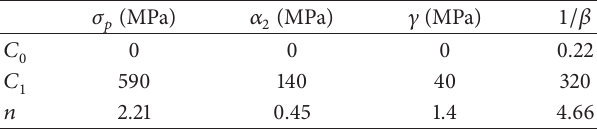
Table 2: Material constants for aluminum foam [24].